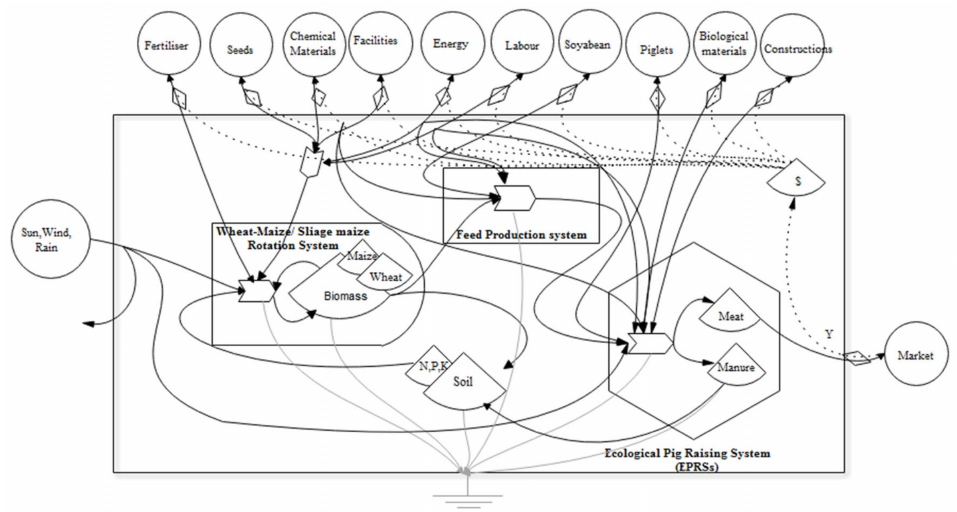
Figure 2. Aggregated system diagrams of